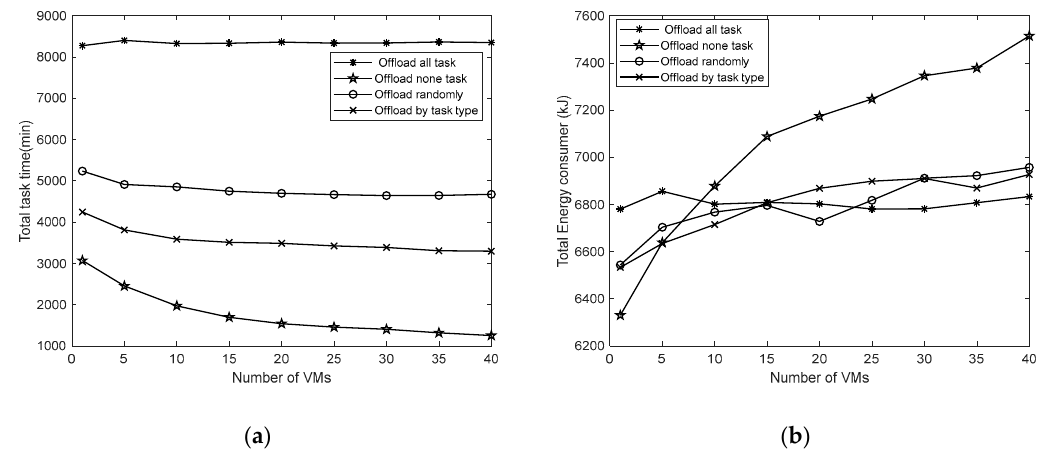
Figure 8. ( a ) the impact of task offloading strategy on the total time spent; ( b ) the impact of task offloading strategy on total energy consumption.